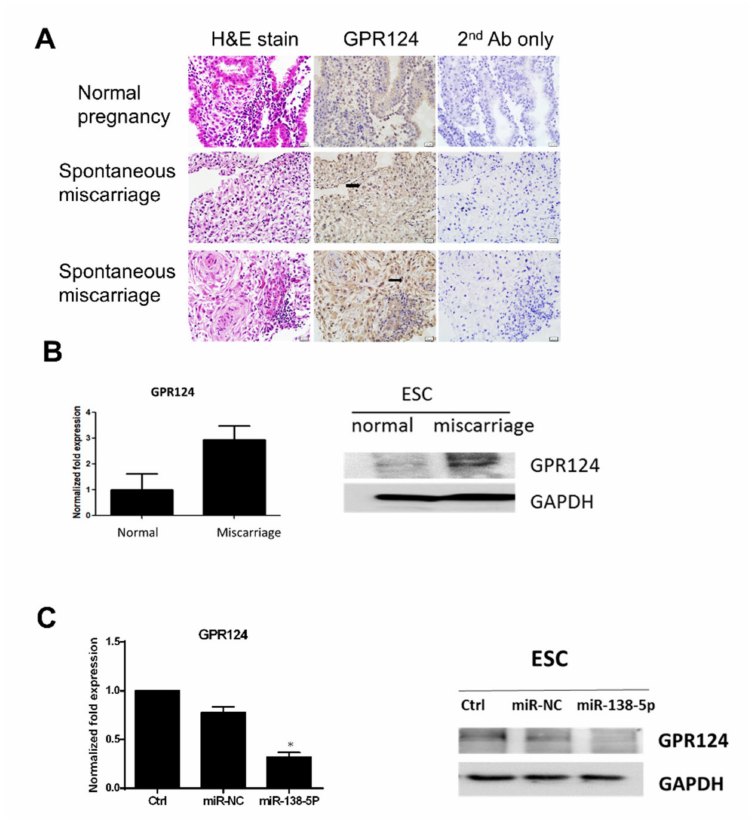
Figure 4. GPR124 expressions in endometrial stromal cells are examined by immunohistochemistry, quantitative real-time PCR and immunoblot analysis. ( A ) Immunohistochemistry of decidual en- dometrium sections; column 1, hematoxylin and eosin staining; column 2, GPR124 (brown staining) stromal cells (arrow) are indicated in row 2; column 3, second antibody only control. Micrographs were taken with the 400 × objective lens. Scale bars represent 20 µ m. ( B ) The expressions of GPR124 mRNA and protein in endometrial stromal cells of normal early pregnancy and spontaneous miscar- riage were detected by RT-qPCR and immunoblot analysis. ( C ) In the left column, the expression of GPR124 regulated by miR-138-5p at the mRNA level. In the right column, the expression of GPR124 regulated by miR-138-5p at the protein level. Analysis for expression of miR-138-5p and GPR124 mRNA and protein showed a significant and inverse correlation between miR-138-5p and GPR124 in endometrial stromal cells. miRNA negative control (miR-NC). ESC—endometrial stromal